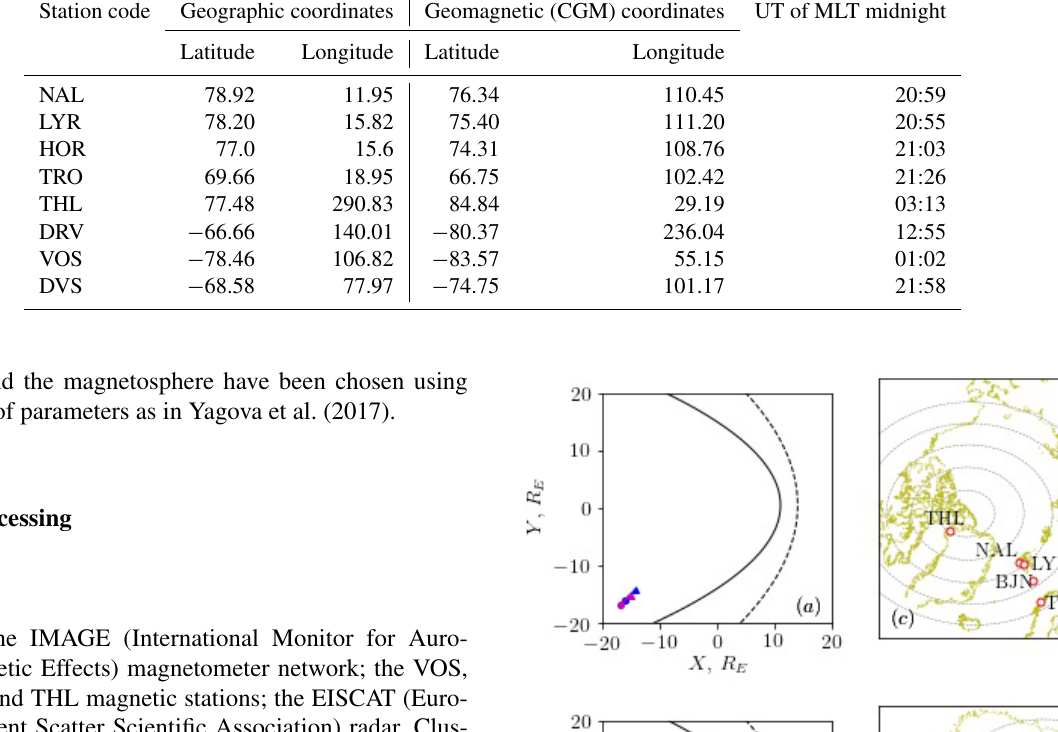
Table 1. Station coordinates and their parameters. Station code